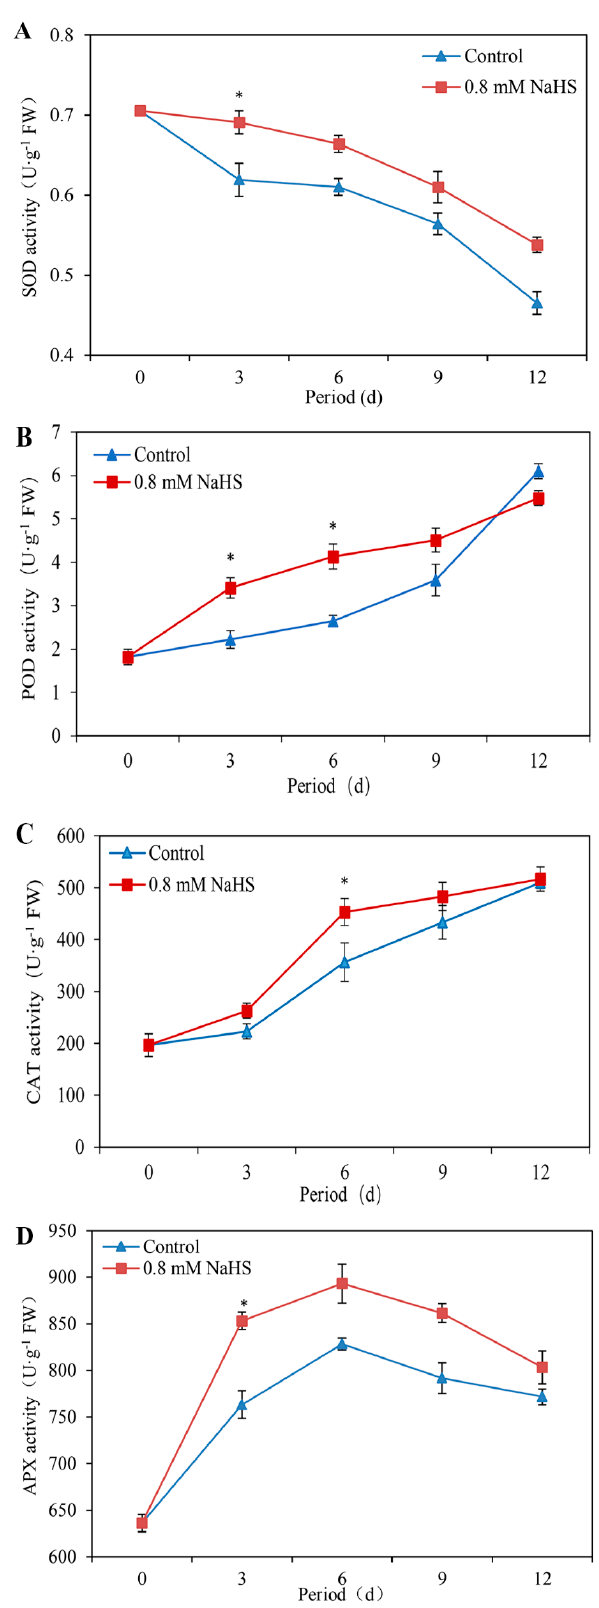
Figure 6. Changes in enzyme activities in Lanzhou lily scales with or without 0.8 mM NaHS treatment during storage at room temperature for 12 days. ( A ) SOD, superoxide dismutase; ( B ) POD, peroxidase; ( C ) CAT, catalase; ( D ) APX, ascorbic acid peroxidase. The error bars denote the standard errors ( n = 3). The asterisks denote Duncan’s multiple range test for significance: * p <0.05. d: days. As shown in Figure 6D, the APX activity in scales with or without NaHS treatment first increased but then decreased throughout the storage period. Compared with that in the control scales, the APX activity in the NaHS-treated scales markedly differed on day